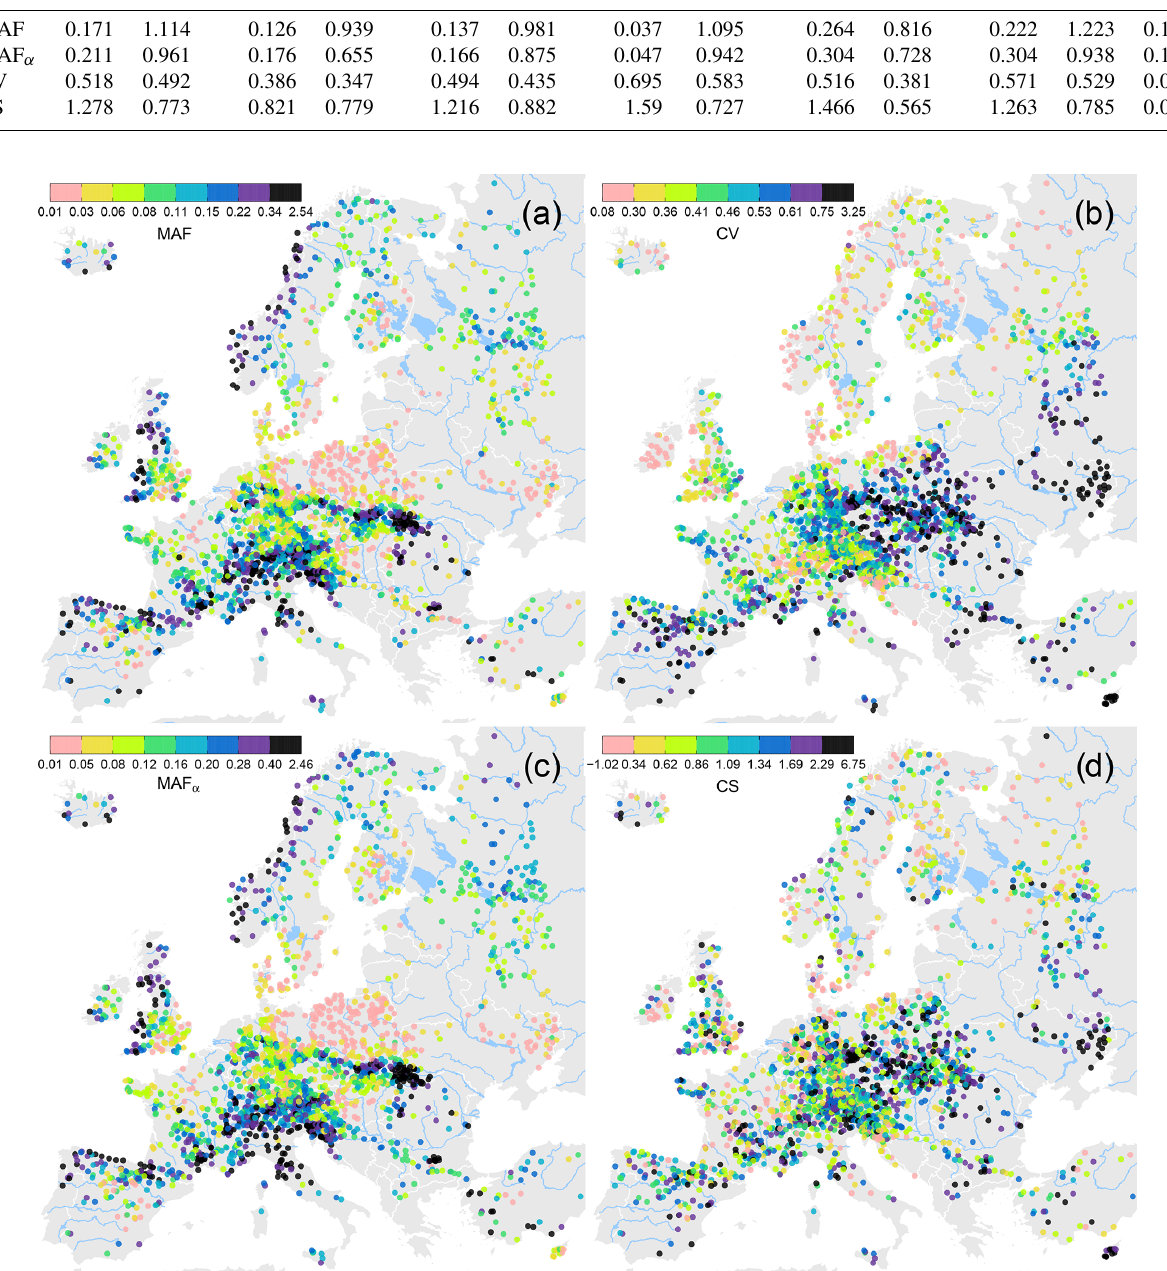
Figure 2. Mean specific flood (MAF, m 3 s − 1 km − 2 ) (a) , CV (b) , mean specific flood normalized to a catchment area of 100km 2 (MAF α , m 3 s − 1 km − 2 ) (c) , and coefficient of skewness (CS) (d) . Colours represent the estimate partitioned into eight classes of equal